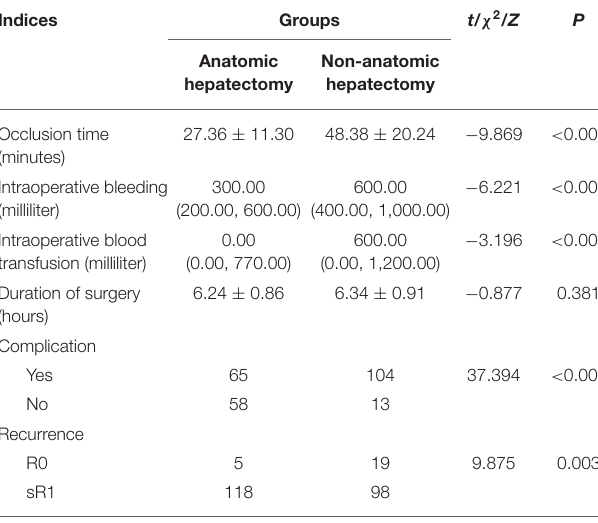
TABLE 2 | Comparison of intraoperative and postoperative data between the two